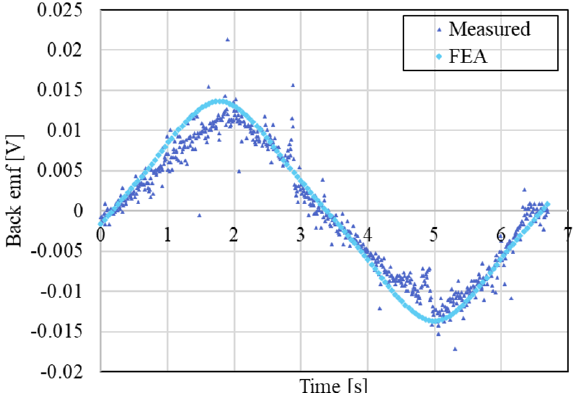
Figure 10. Soft magnetic composite (SMC)-based stator components might change their magnetic properties whilst they are machined in real life. This might be one of the reasons that the measured and simulated results in Figure 10 do not match perfectly.